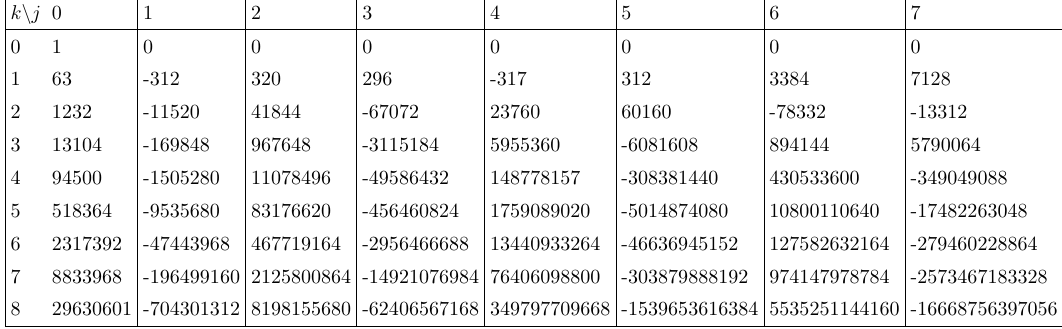
Table 32. Table of b jk coe(cid:14)cients for h SU(8)